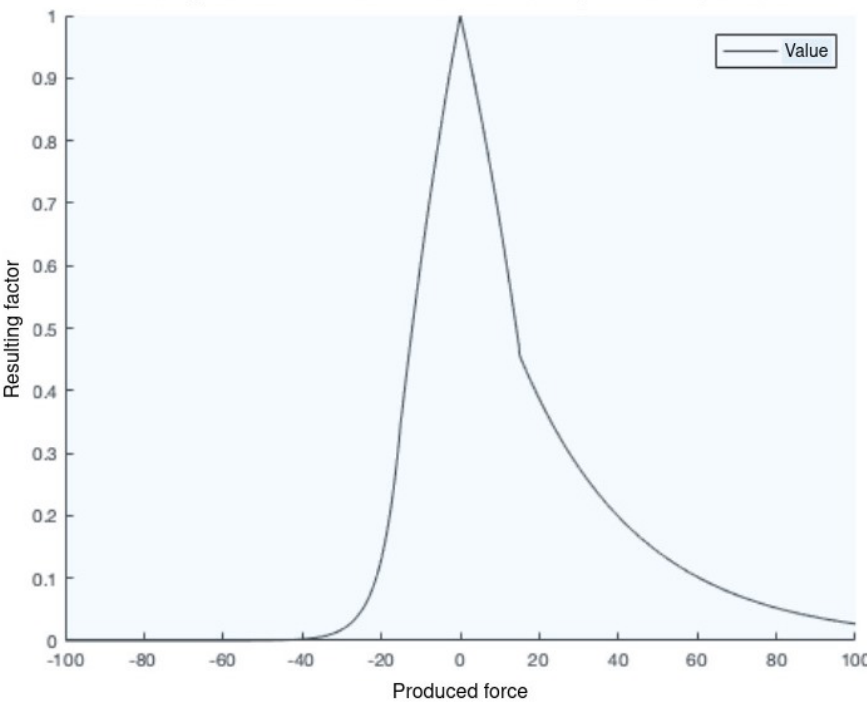
Figure 2. Distance scaling